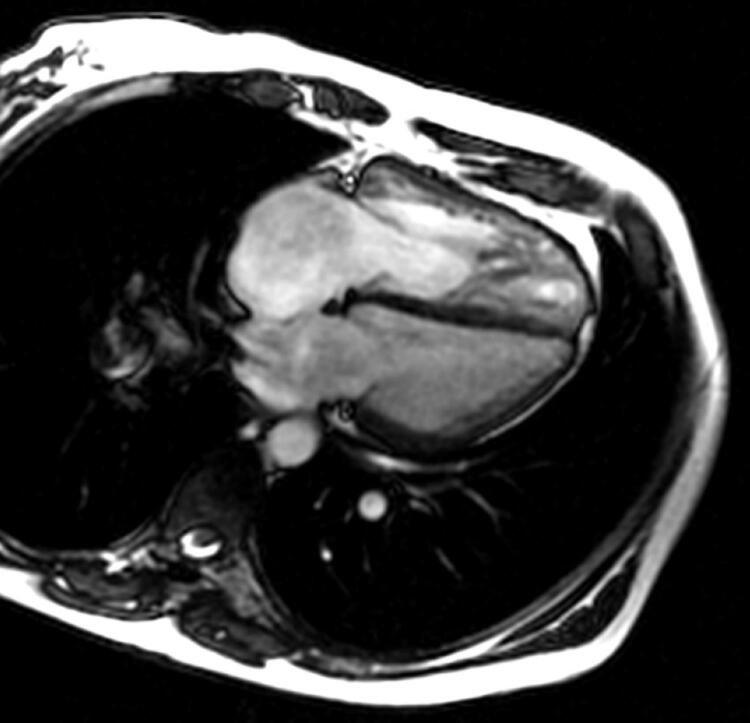
– Cardiac magnetic resonance imaging showing interatrial communication.